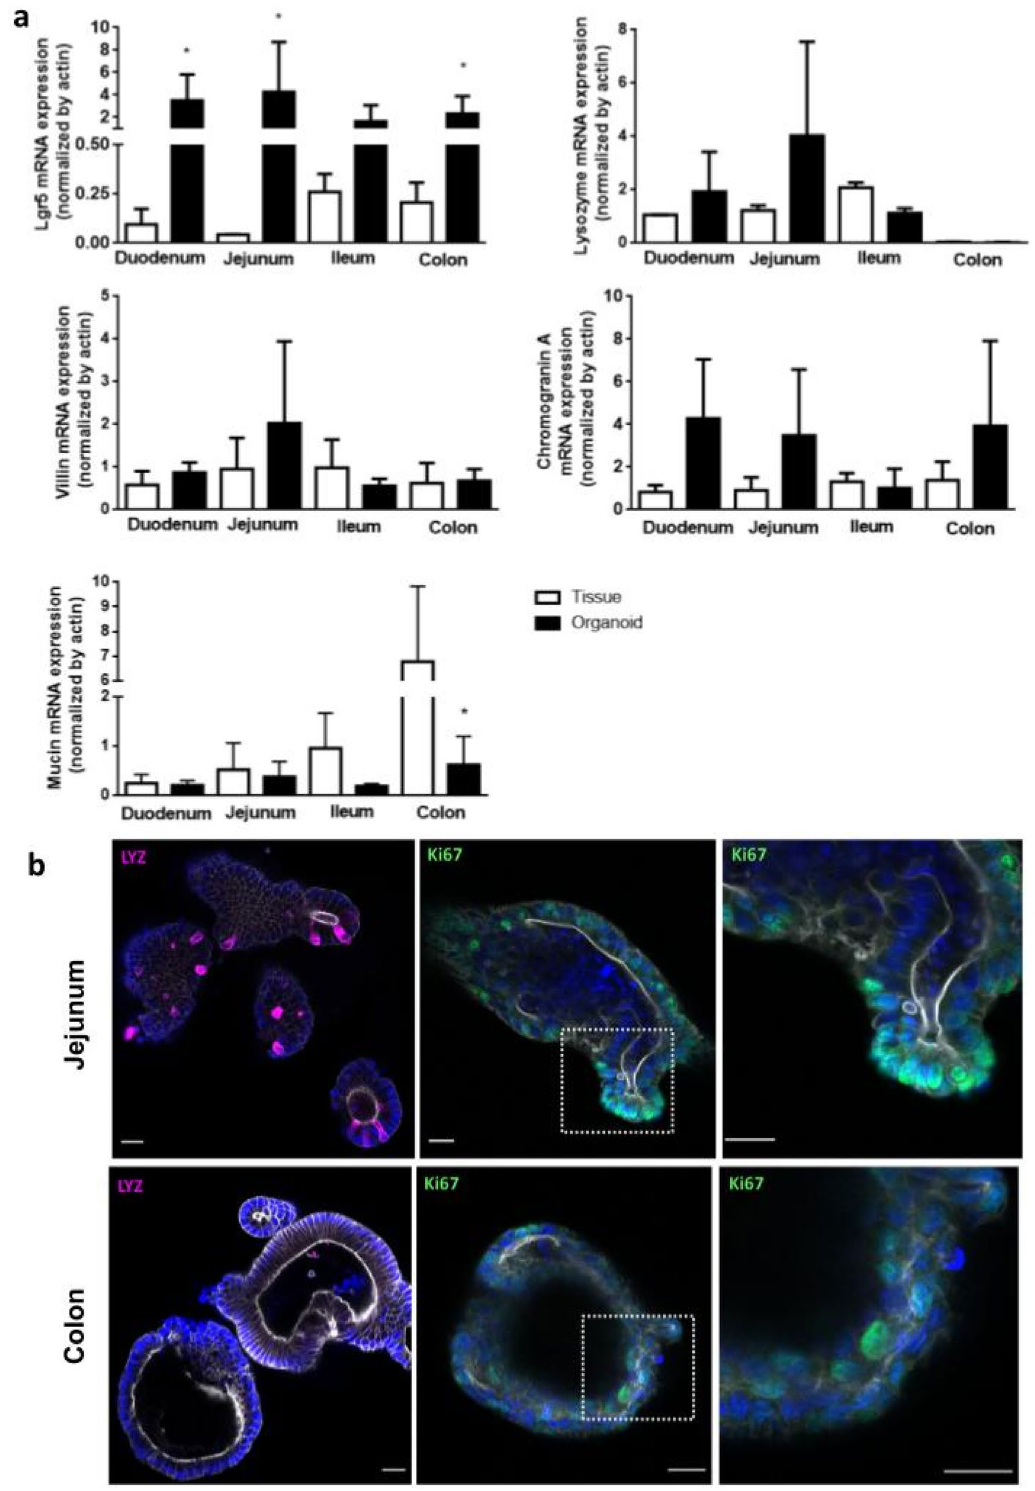
Figure 3. Specific intestinal markers for cell populations in organoid cultures. ( a ) The presence of the major intestinal cell types where analyzed by qPCR for specific intestinal markers: intestinal stem cells (Lgr5), enterocytes (Villin); Paneth cells (Lysozyme), Goblet cells (Mucin 2) and enteroendocrine cells (Chromogranin A). The mRNA levels of each marker were normalized by actin expression. Data was expressed as mean ± SD of two (tissue) or at least three (organoids) different animals. * P < 0.05, significant differences between the intestine tissue and the corresponding derived-organoid. ( b ) Detection of Paneth cells (Lysozyme positive cells in magenta) and proliferating cells (Ki67 positive cells in green) in organoids derived from small intestine and colon by immunofluorescence. Nuclei in blue; actin in gray. Scale bar = 20